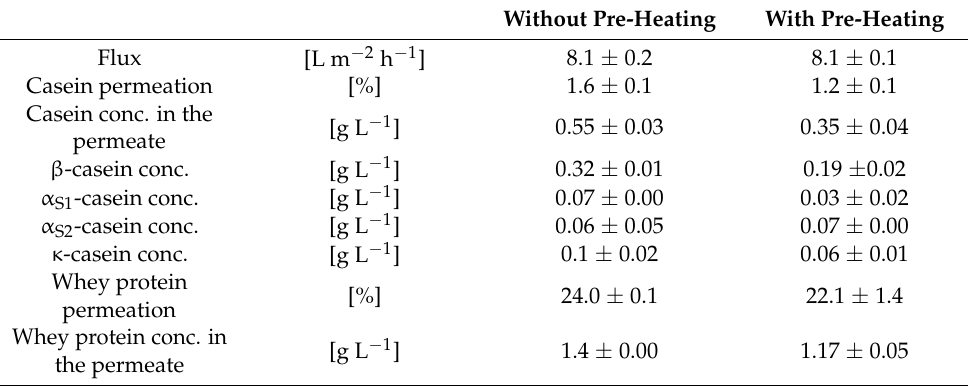
Table 2. Flux, milk protein permeation, and concentration in the permeate during microfiltration (MF) at 10 ◦ C, without and with pre-heating prior to microfiltration. Measured after a process time of 50 min under stable filtration conditions. Without Pre-Heating With Pre-Heating Flux [L m − 2 h − 1 ] 8.1 ± 0.2 8.1 ± 0.1 Casein permeation [%] 1.6 ± 0.1 1.2 ± 0.1 Casein conc. in the [g L − 1 ] 0.55 ± 0.03 0.35 ± 0.04 permeate β -casein conc. [g L − 1 ] 0.32 ± 0.01 0.19 ± 0.02 [g L − 1 ] 0.07 ±